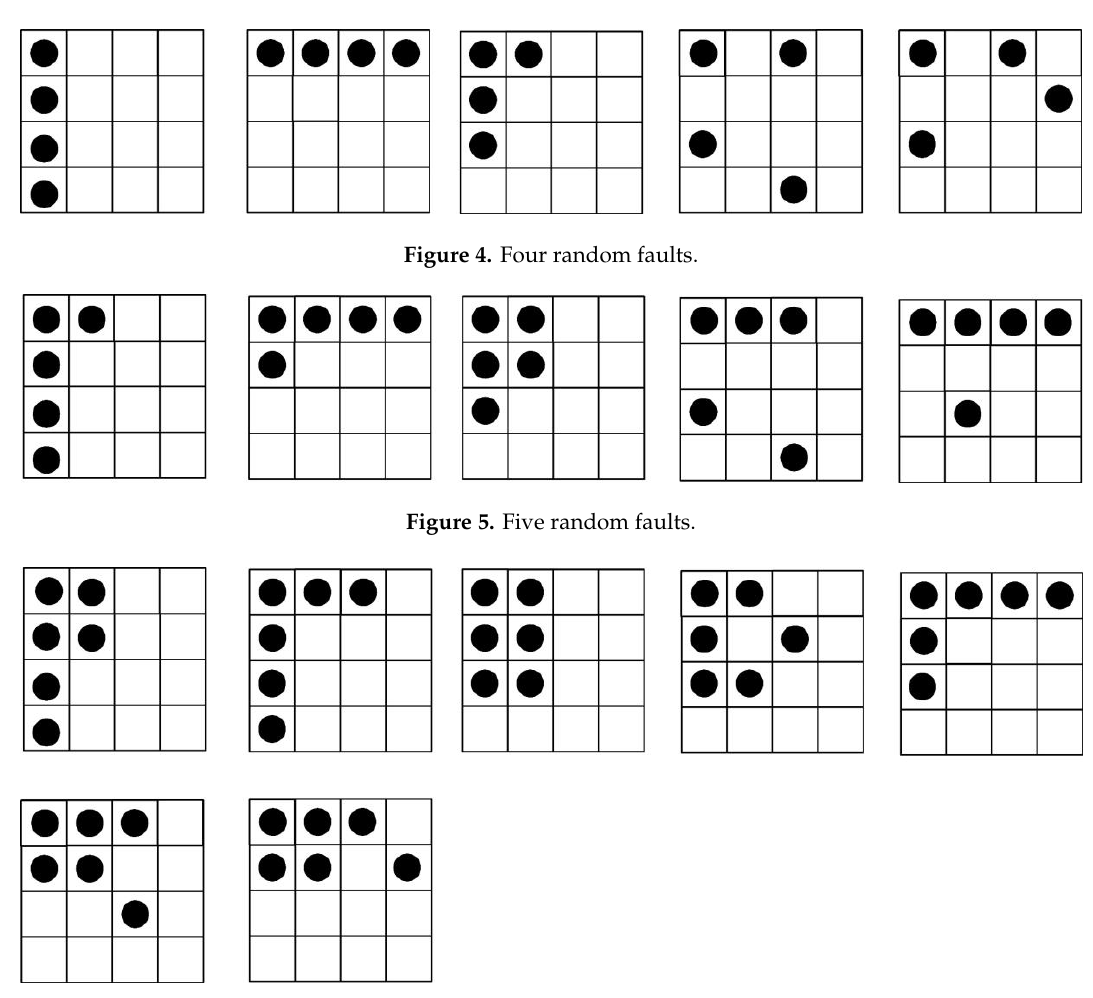
Figure 6. Six random